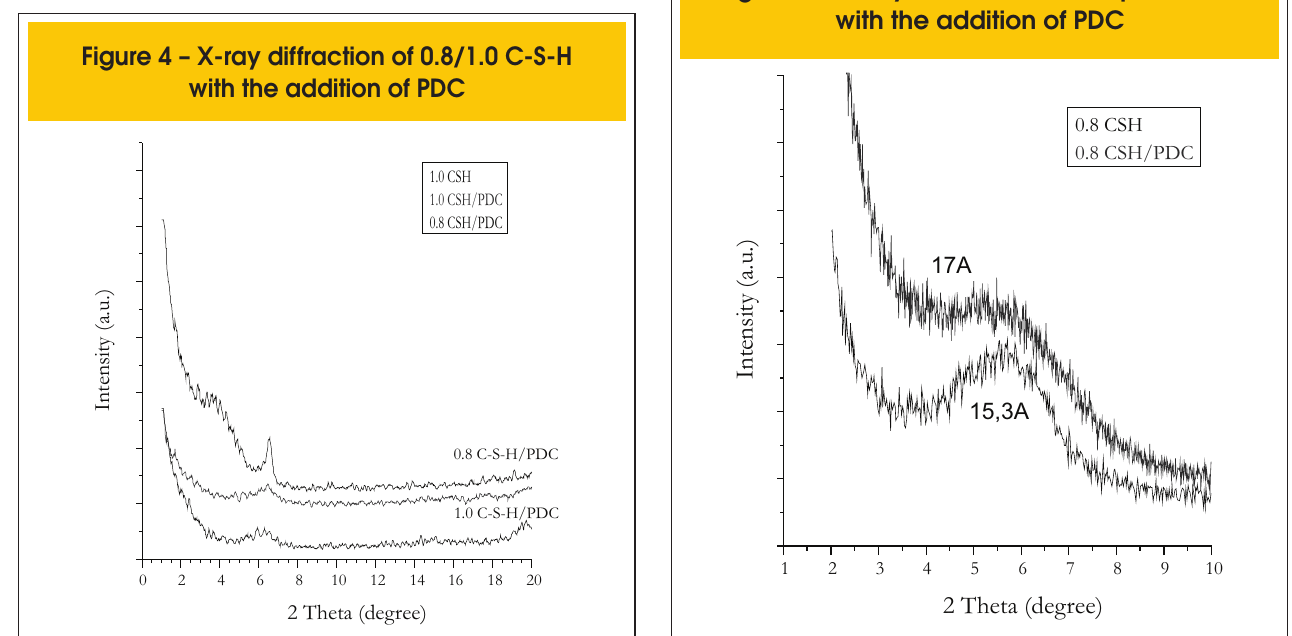
Figure 4 – X-ray diffraction of 0.8/1.0 C-S-H with the addition of PDC